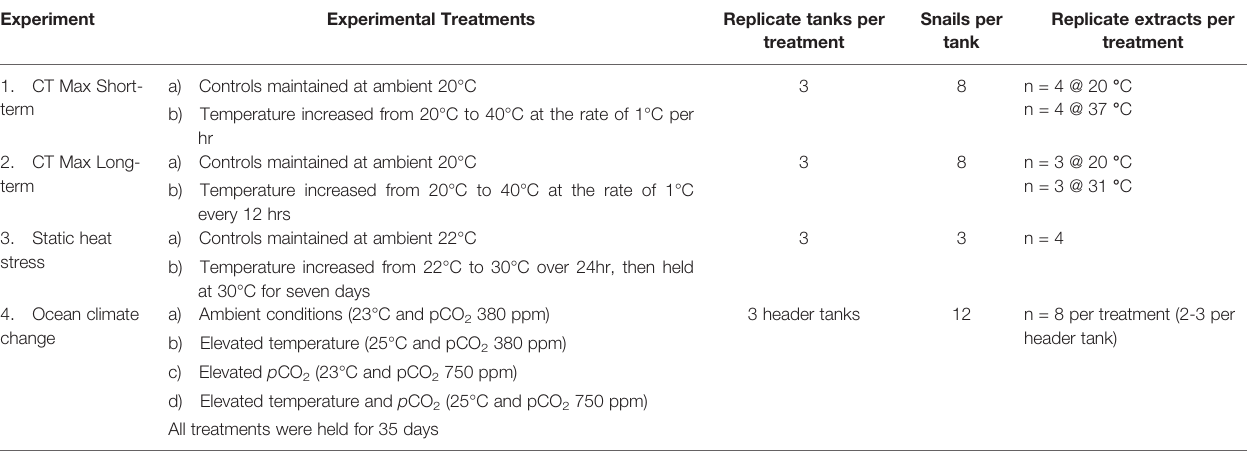
TABLE 1 | Summary of the experimental design and number of independent replicates analyzed for testing the effects of heat stress on Dicathais orbita secondary metabolites across four separate manipulative experiments. Experiment Experimental Treatments Replicate tanks per